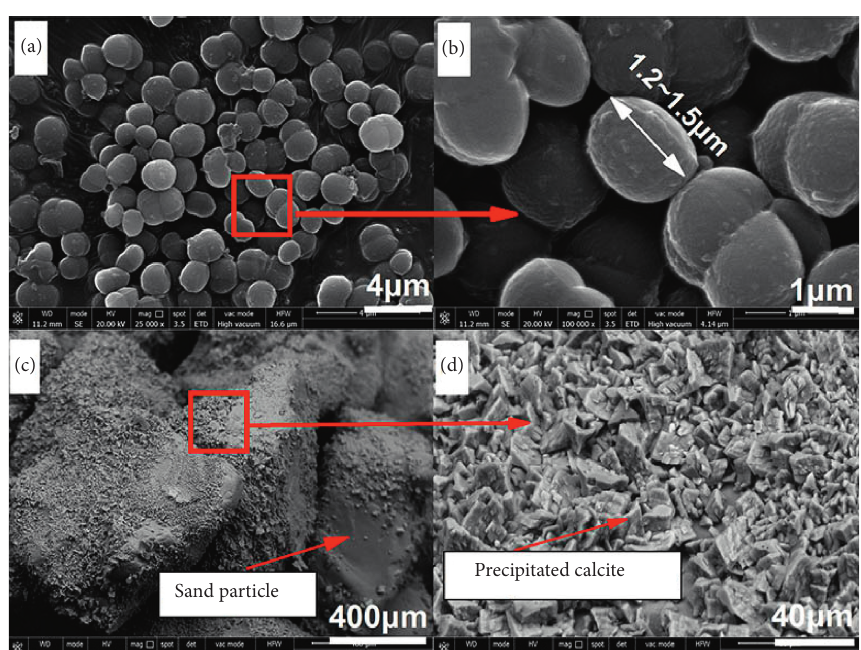
Figure 6: SEM images: (a) Staphylococcus. (b) The shape of Staphylococcus at magnification. (c) The surface and surrounding of the particles are filled with calcium carbonate. (d) Precipitated calcium carbonate induced by